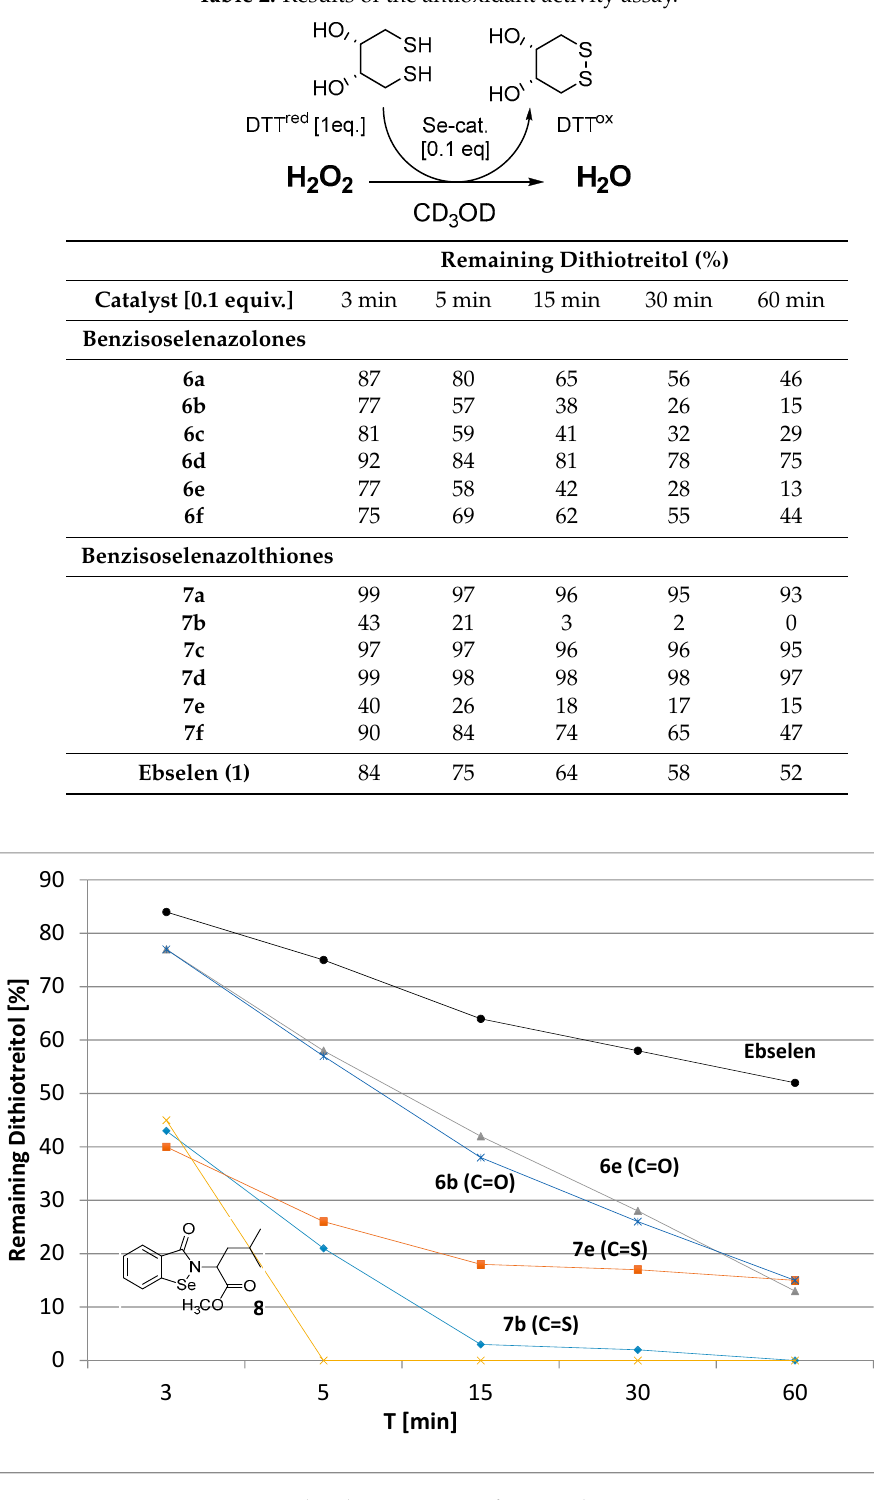
Table 3. Cytotoxic activity evaluated in vitro . Compound